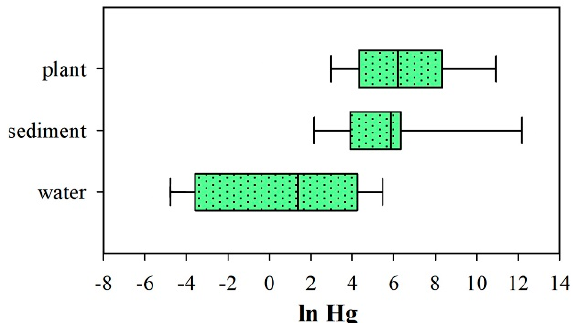
Figure 5. Heavy metal concentrations in water, sediments, and plants.